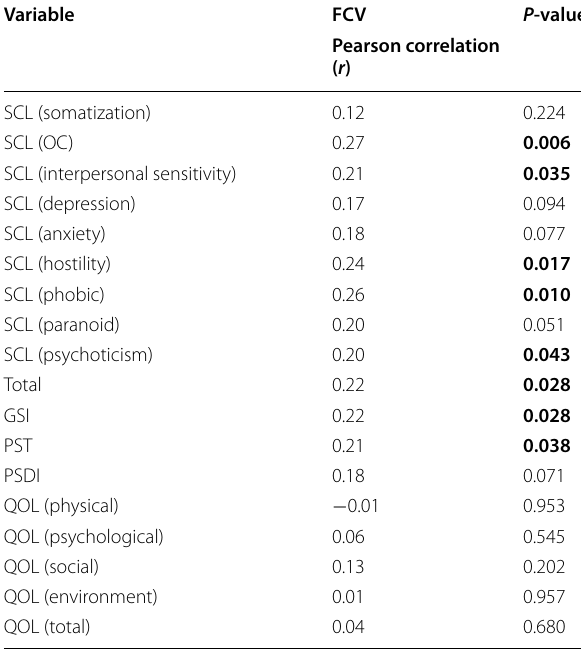
Table 4 Correlation between perceived fear of COVID-19 infection and associated psychological symptoms and quality of life in patients with